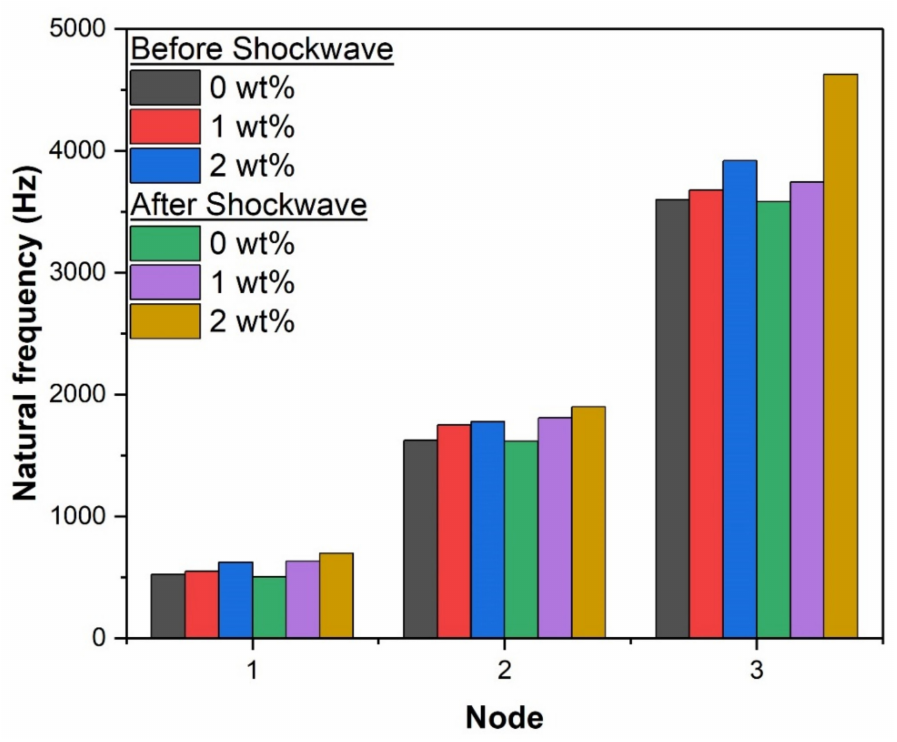
Figure 12. Natural frequency value before and after shock wave treatment. Table 2. Natural frequencies (Hz) before shock wave treatment.